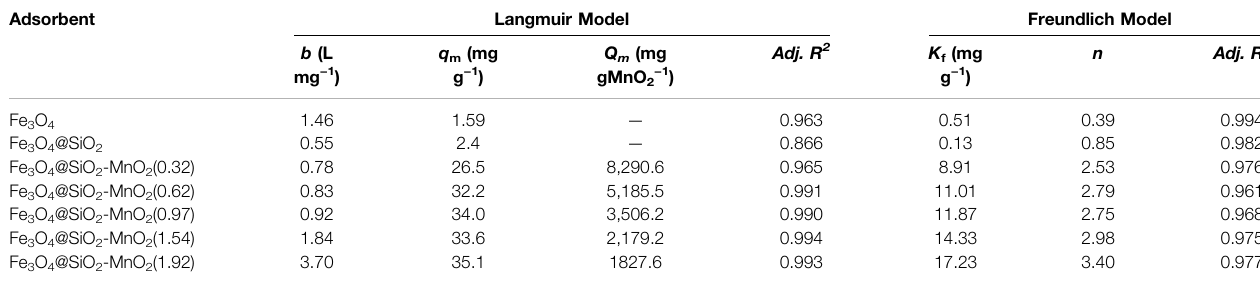
TABLE 2 | Fitting parameters of the Langmuir and Freundlich isotherm models for adsorption of Pb(II) onto the adsorbents.